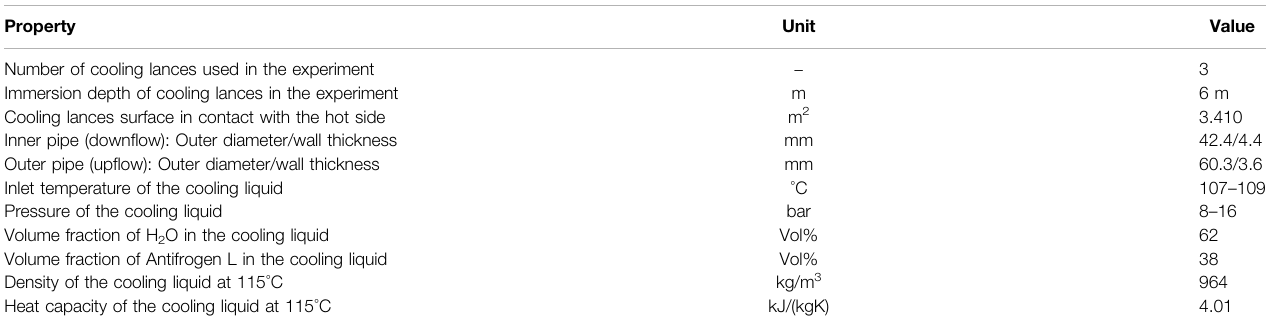
TABLE 2 | Properties of the cooling lances and cooling